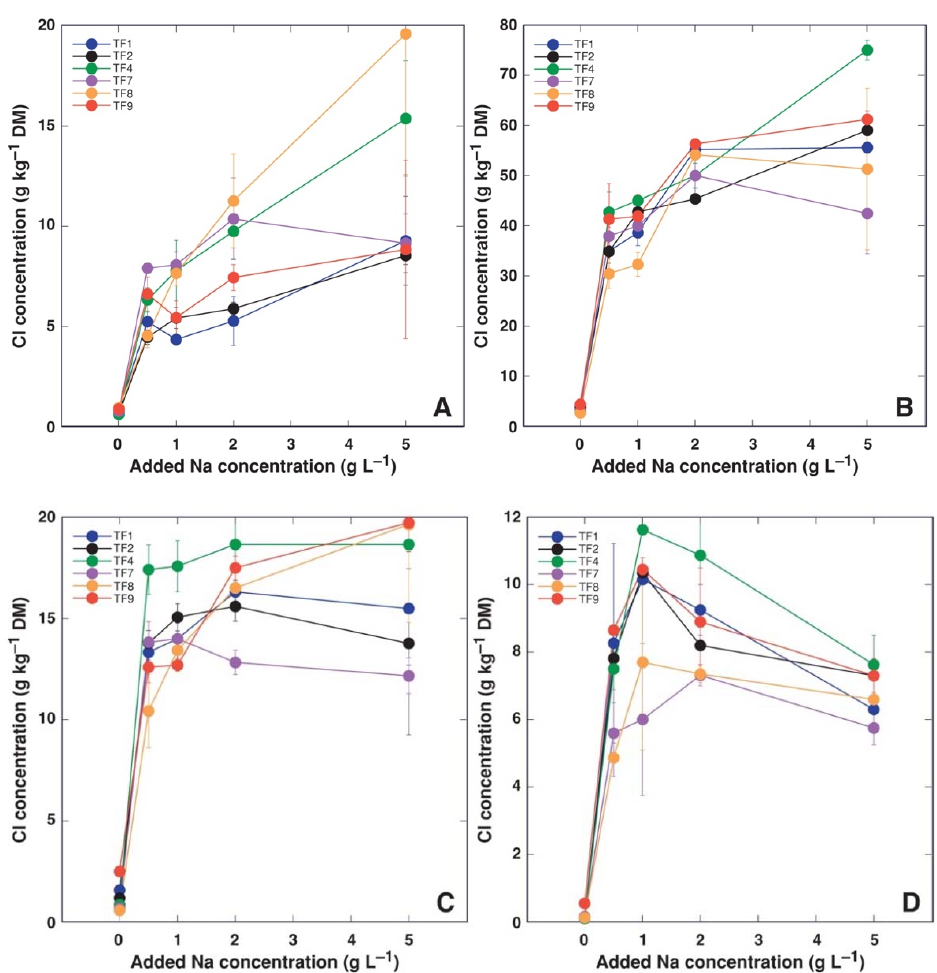
Figure 8. Effect of increasing substrate salinity on Cl − accumulation in leaf blades ( A ), leaf petioles ( B ), stolons ( C ) and roots ( D ) of Trifolium fragiferum plants of different accessions.